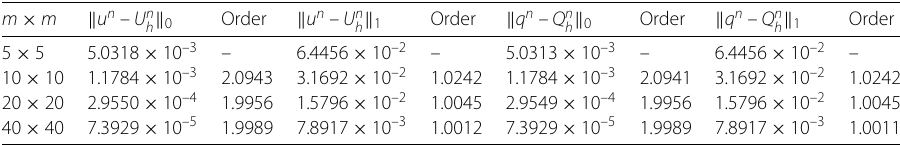
and Q n when t = 0.75 ( τ = 5 h 2 ) h h